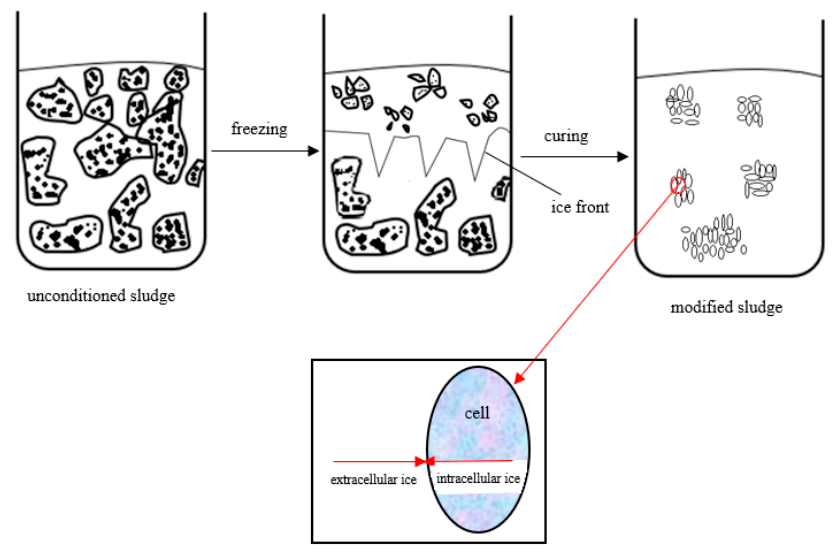
Figure 7. Effect of freezing/thawing on sludge microbe cells.